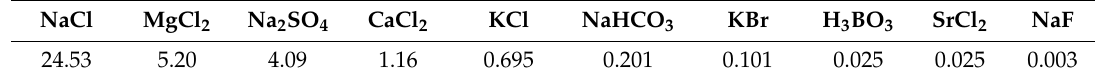
Table 3. Synthetic seawater composition in gm / L [34].